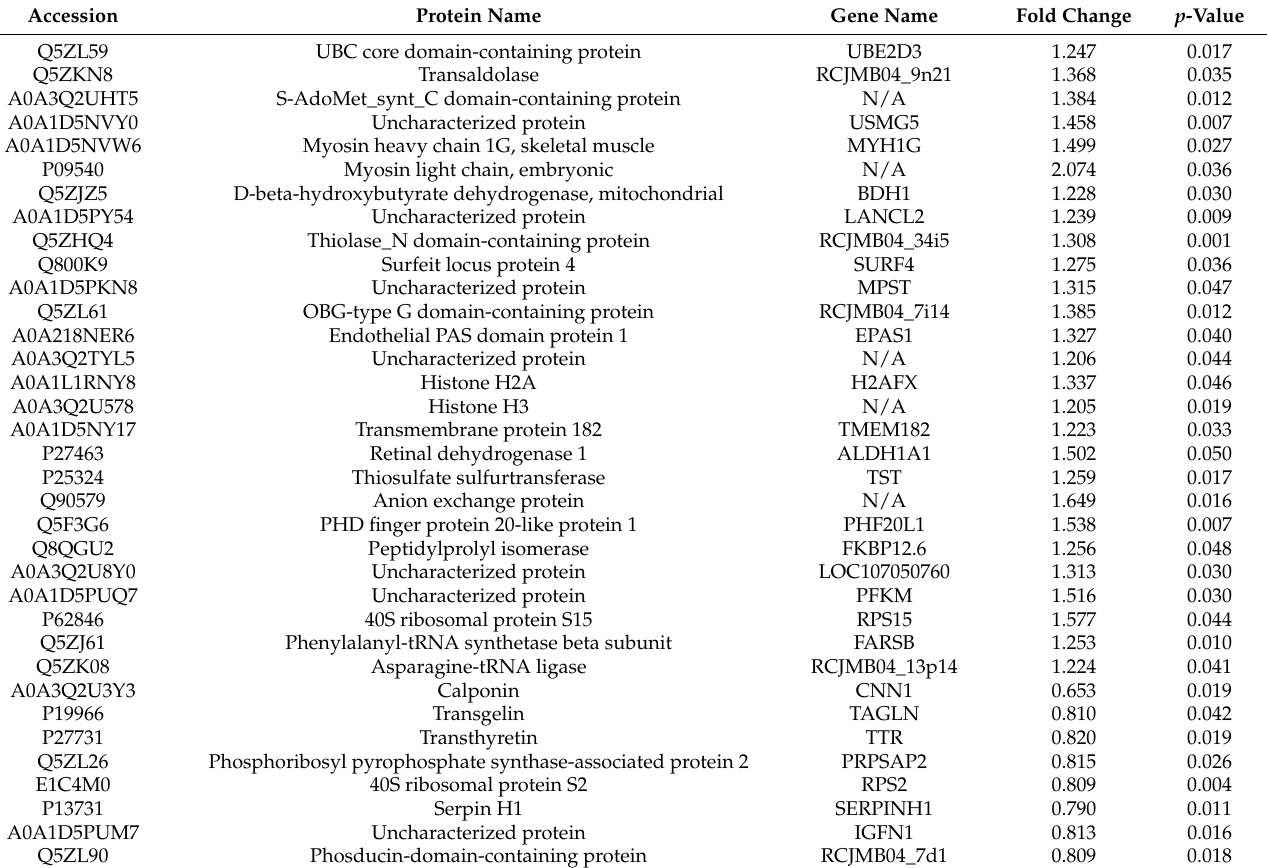
Table 7. List of DAPs identified by iTRAQ analysis in breast muscle of broilers fed betaine